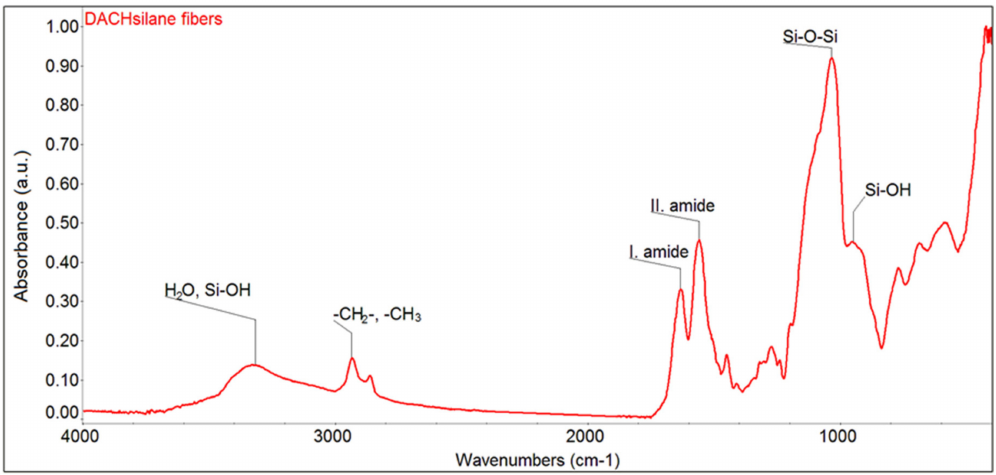
Figure 3. FTIR spectra of the prepared hybrid DACHsilane fibres made of compound 1